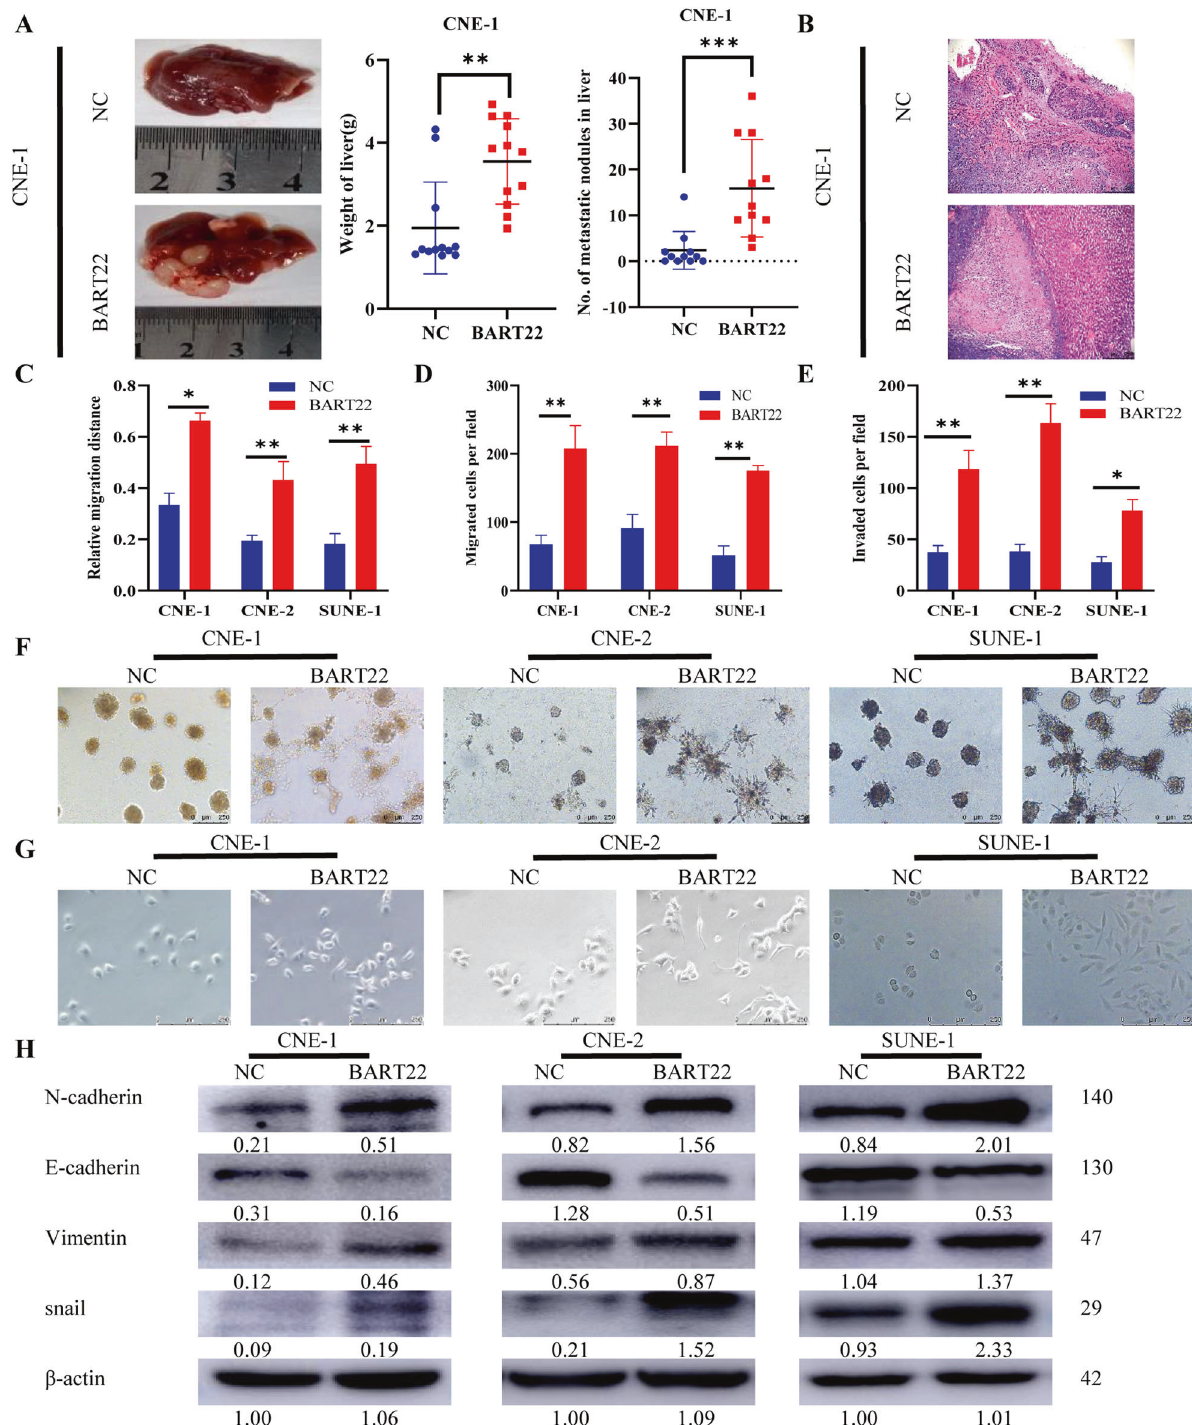
Fig. 4 Overexpression of EBV-miR-BART22 promotes the migration, invasion, and EMT of NPC cells. A A representative bright- fi eld image of the livers was shown. Liver weights and metastatic modules number in nude mice that received transplants of indicated cells. Bars correspond to mean ± standard deviation (SD), ** P < 0.01. *** P < 0.001. ( B ). Representative H&E staining of indicated spleen orthotopic tumors is shown. C CNE-1, CNE-2, and SUNE-1 cells and appropriate controls were used in a wound-healing assay. D Quanti fi cation of indicated migrating cells in 5 random fi elds analyzed by Transwell assays, respectively. E Quanti fi cation of indicated invasion cells in 5 random fi elds analyzed by invasion assays, respectively. F Representative micrographs of indicated cells grown on matrigel for 10 days in 3D spheroid invasion assay. G Cells morphology was evaluated by phase-contrast microscopy. H Expression of epithelial cell marker and mesenchymal cell marker in indicated cells were examined by WB analysis. β -actin was used as a loading control.